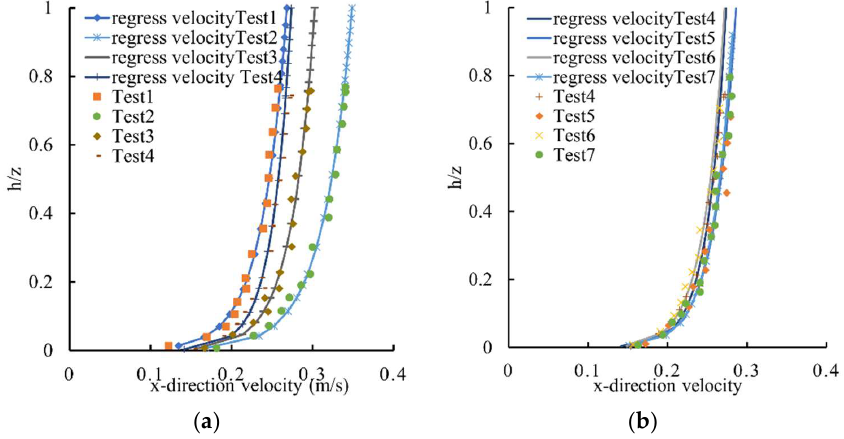
Figure 3. U component normalized by the water depth h ( a ) with an approximately water depth ( b ) with an approximately mean velocity. Table 1. Experiment